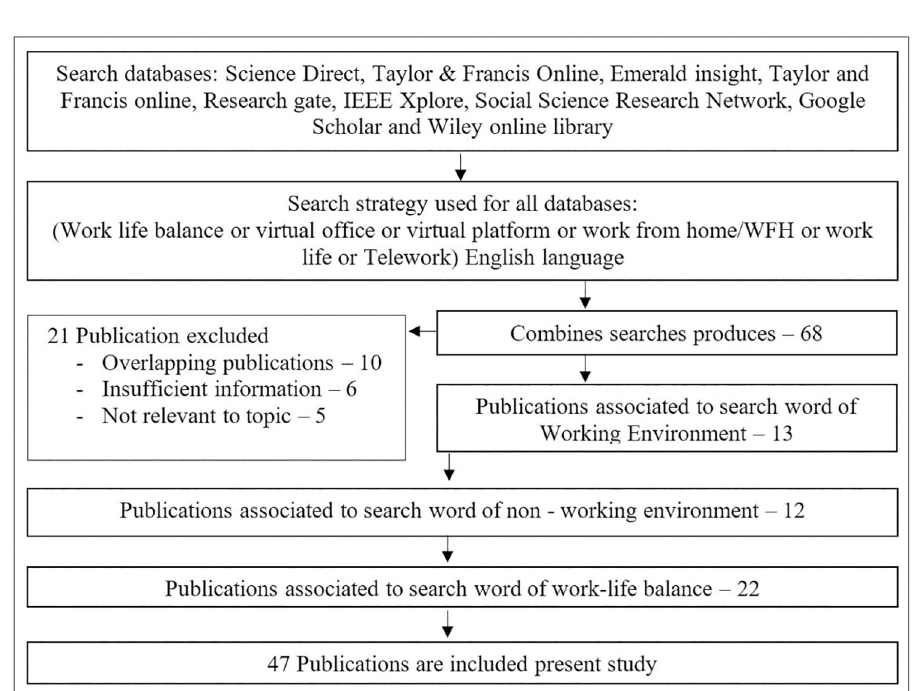
Fig 1. Literature search flow diagram. Source: Based on authors’